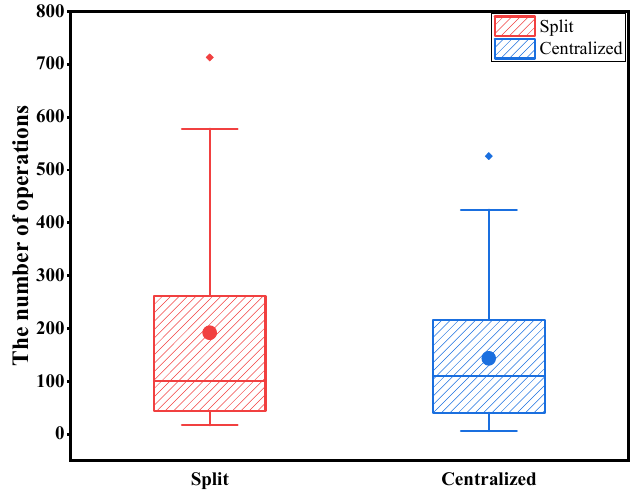
Figure 5. Boxplots of the average daily operating-system duration of two type mechanical ventilation systems in different seasons.